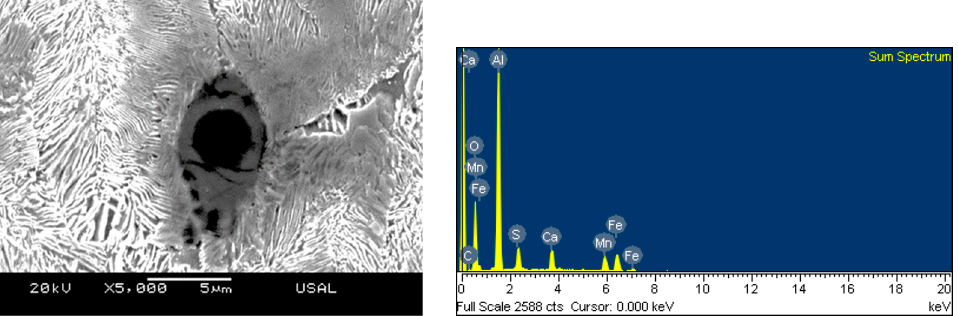
Figure 5. Inclusion of mix -type class, with complex oxide composition in the inner central zone and manganese sulfide in the outer zone, present in the initial wire rod E0.